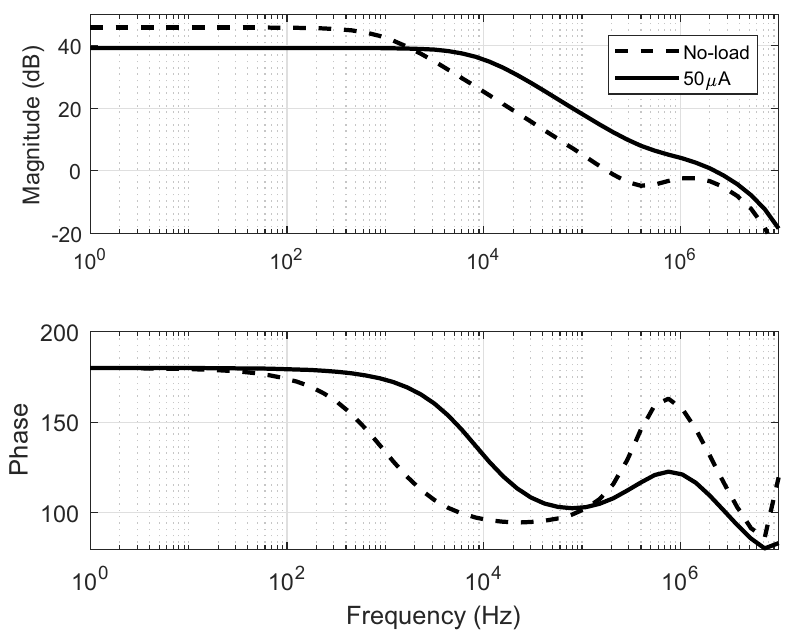
Figure 6. Simulated loop gain of the proposed LDO under no-load and 50 µ A